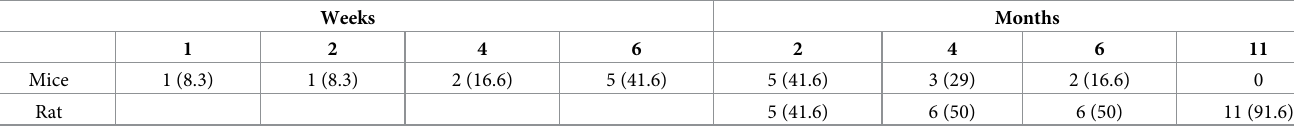
Table 1. Frequency of ossified matrix with bone marrow areas inside rodent